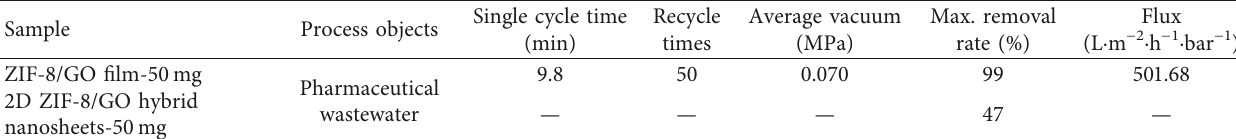
Table 7: Comparison of adsorption properties of different